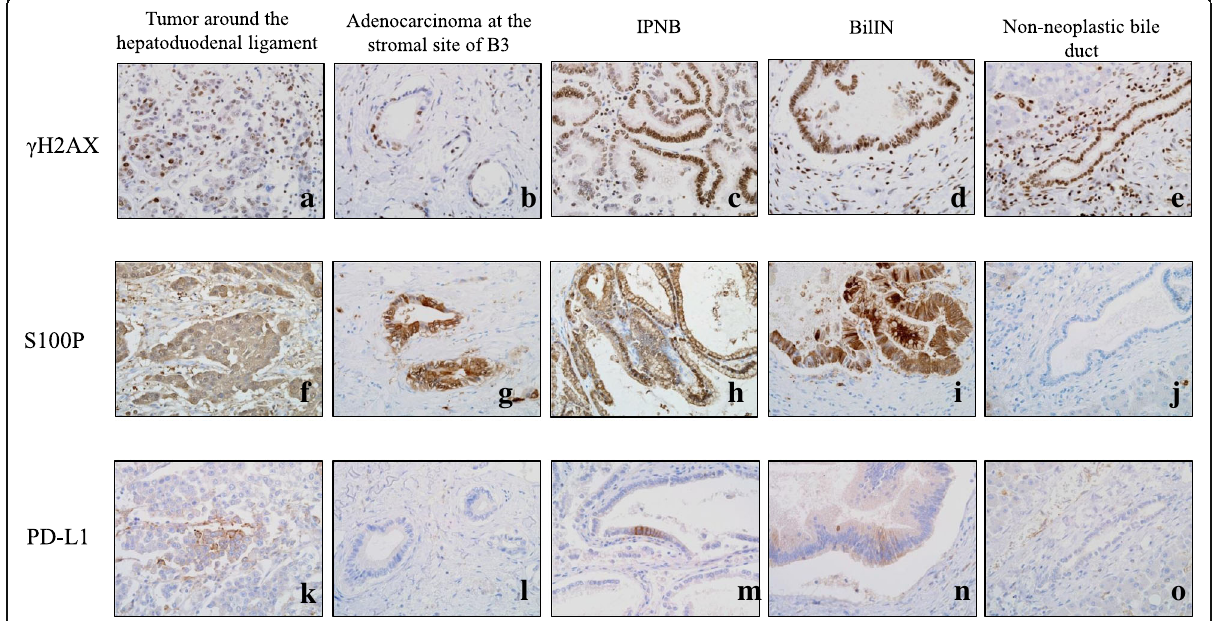
Fig. 5 Immunological staining using primary antibodies against γ H2AX ( a – e ), S100P ( f – j ), and PD-L1 ( k – o ). Positive expressions of γ H2AX and S100P were detected in almost all portions of invasive carcinoma, BilIN, and IPNB in the large bile ducts. Although γ H2AX expression was also detected within the non-neoplastic biliary epithelium, similar to BilIN, IPNB, and invasive carcinoma, S100P expression was absent or relatively weak in the non-neoplastic epithelium ( a – j ). PD-L1 expression was absent in the stromal cells in the tumor at segment 3 of Glisson ’ s sheath ( l ) and the non-neoplastic epithelium ( o ). Positive PD-L1 expression was partially detected in the tumor cells of the enlarged mass in the hepatoduodenal ligament ( k ), BilIN ( m ), and IPNB ( n